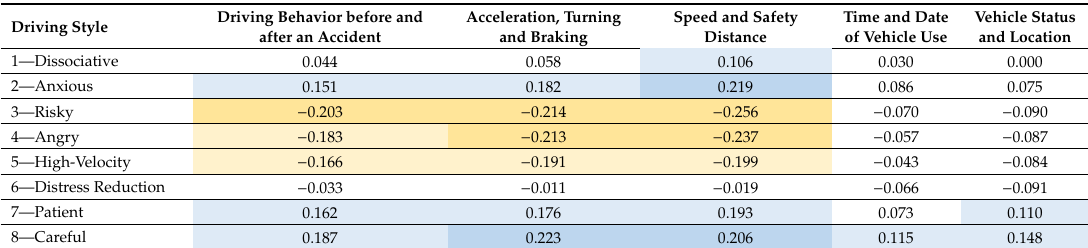
Table 8. Correlation (R) between self-assessment of driving style and willingness to share information. The background indicates the level of correlation between the variables: blue is positive, ochre is negative. Color saturation indicates the magnitude of the correlation.